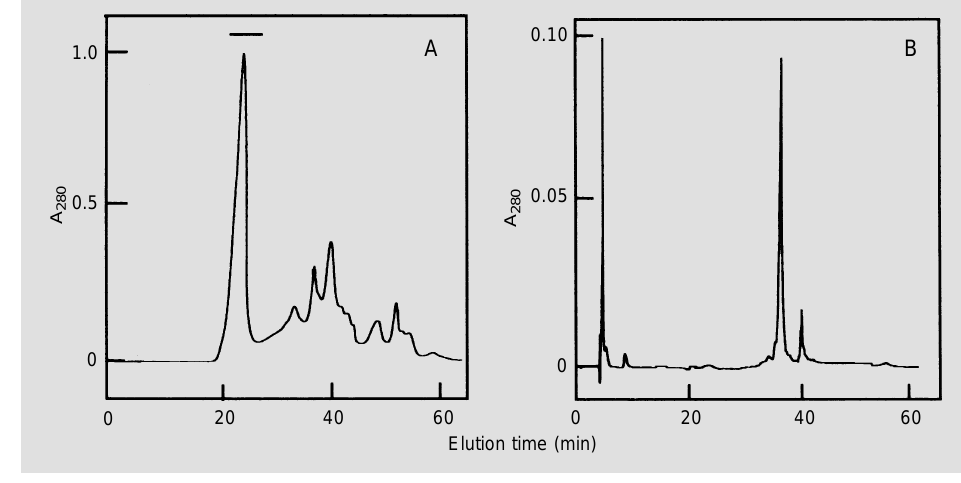
Figure 3 - Assessment of the ho- mogeneity of the 6.5-kDa protein purified from the seeds of O. fi- cus-indica by SDS-PAGE. Purified protein (2 µg) was added to lane 2 and crude albumins (20 µg) are shown in lane 1. Molecular weight markers are indicated on the